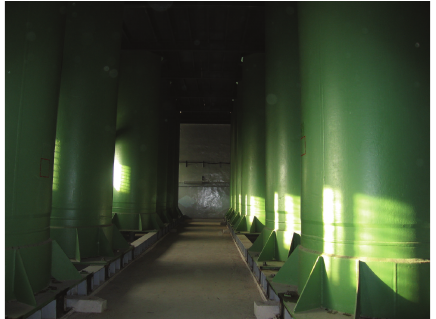
Figure 1: Photo of the ECCS PT in Building 117/1 [3].